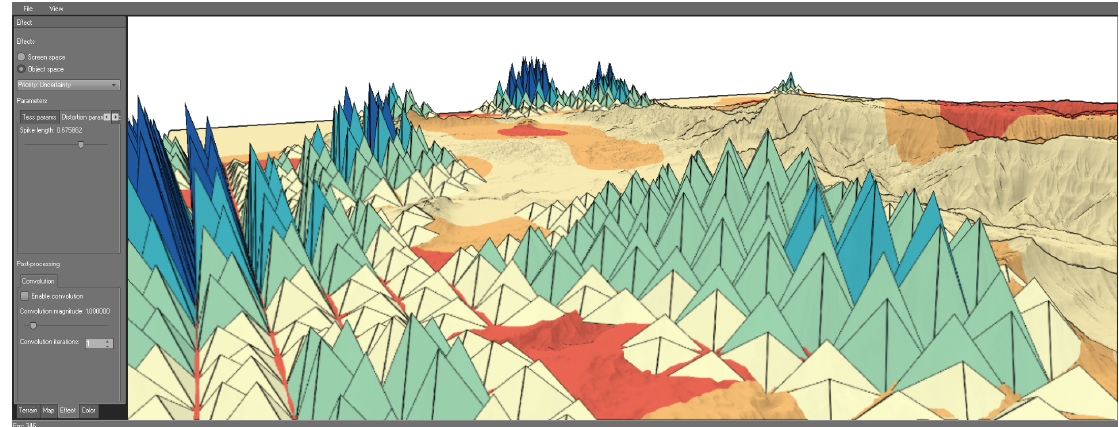
Figure 6. Visualizing hazardous weather regions and associated uncertainty information in 3D